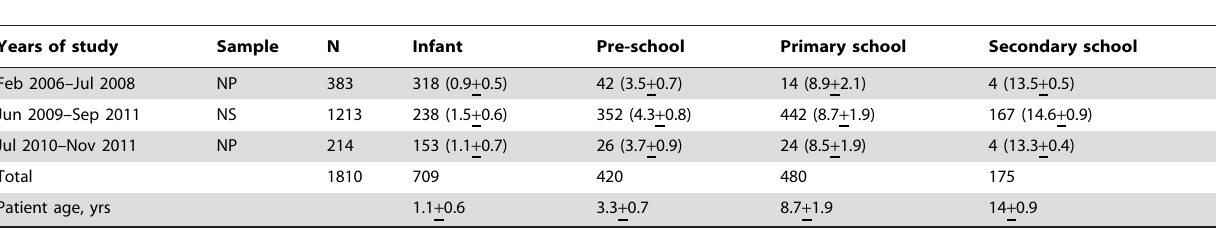
Table 1. Main characteristics of the study populations and respiratory